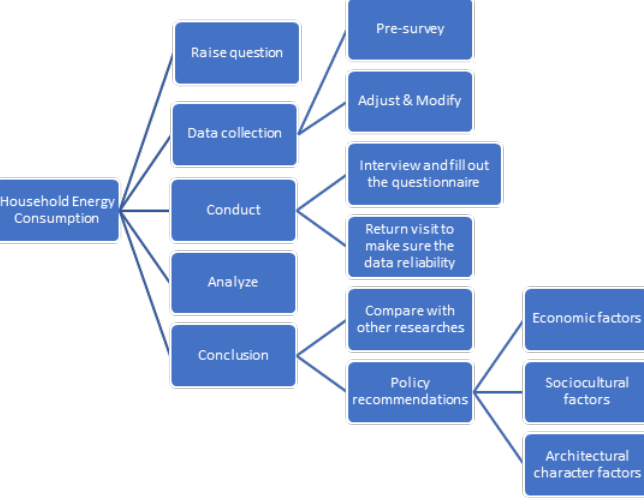
Figure 1. The framework of the paper.